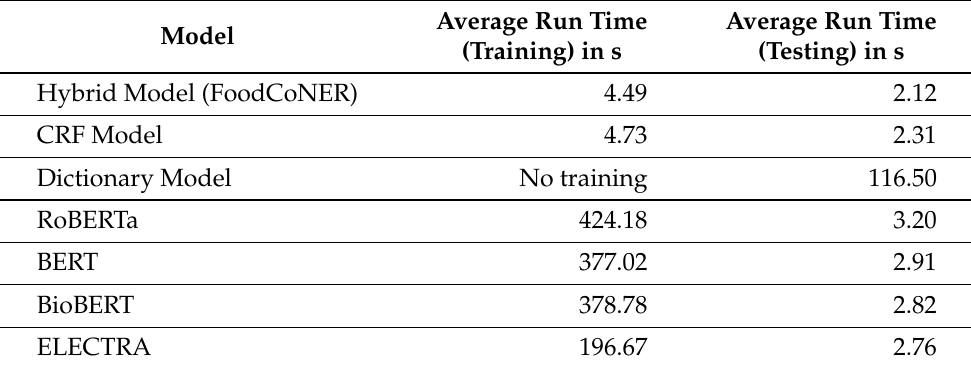
Table 6. Comparison of run times (in seconds) for training of the models and testing. (i) Hybrid model FooDCoNER, (ii) conditional random fields model and (iii) dictionary-based model, (iv) RoBERTa, (v) BERT, (vi) BioBERT, and (vii) ELECTRA. The models used a 1.59 GHZ Tesla T4